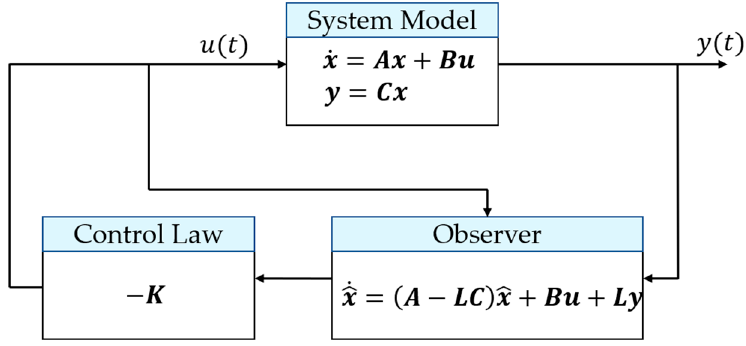
Figure 7. Full State Compensator.